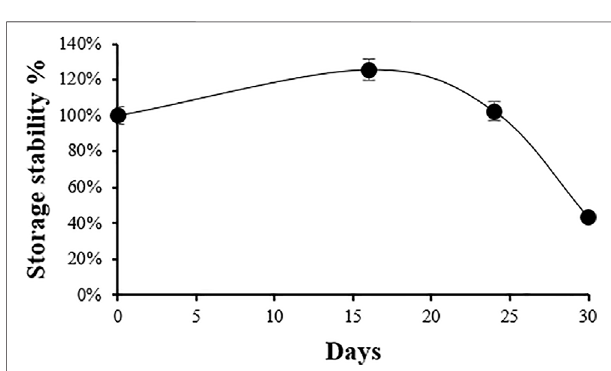
FIGURE 4 | Percentage of storage stability at 4 ° C for the CD – AChE conjugate showing the retention of 43% of initial activity within 30 days.